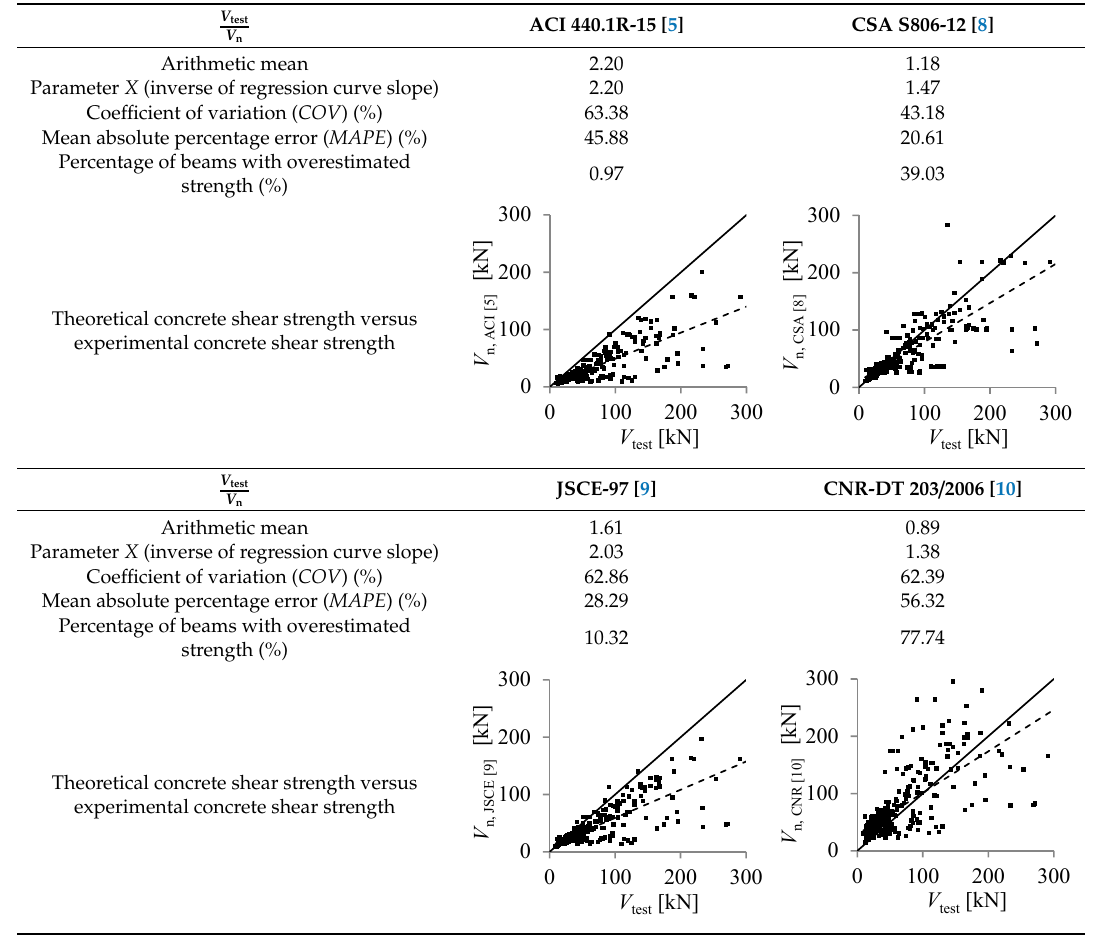
Table 3. Comparison of experimental ( V test ) and theoretical ( V n ) values of the concrete shear strength for available design recommendations. Results according to Equations (2), (7), (13) and (17).